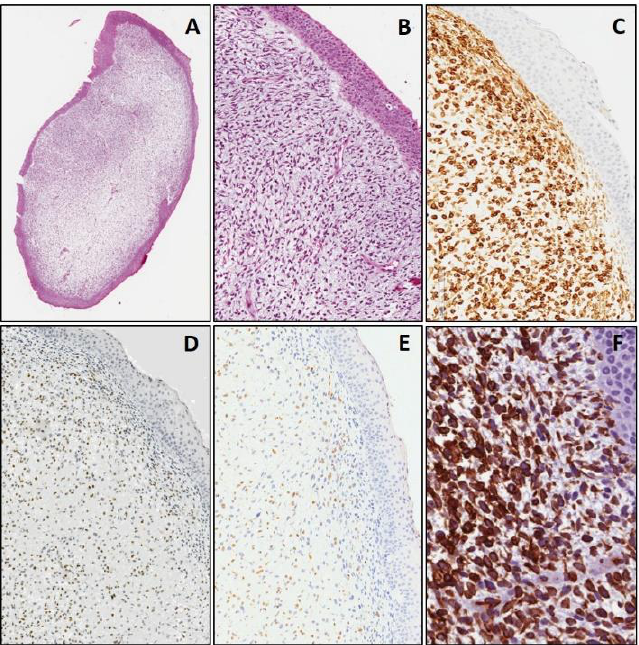
Figure 1. Embryonal rhabdomyosarcoma, botryoid variant. Neoplastic cells beneath epithelial layer, at low ( A ) and higher ( B ) magnification, showing diffuse positivity for myogenic markers: desmin ( C ), myogenin ( D ) and MyoD1 ( E ). Diffuse and strong cytoplasmic staining of neoplastic cells for WT1 ( F ). ( A : original magnification 40×; B – E : original magnification 100×; F : original magnification 200×).